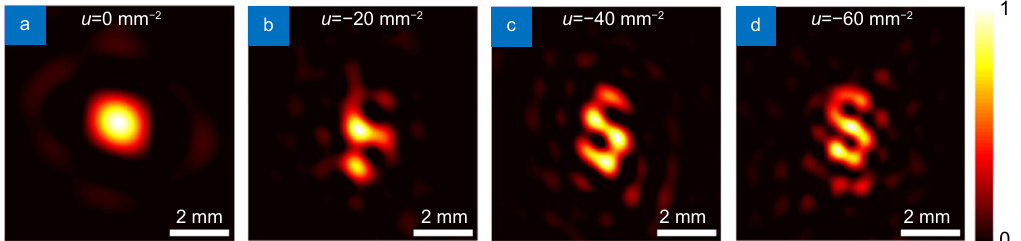
Fig. 6 | Experimental results of the dependence of the quality of the recovered image on the strength factor u in the focal plane in free space